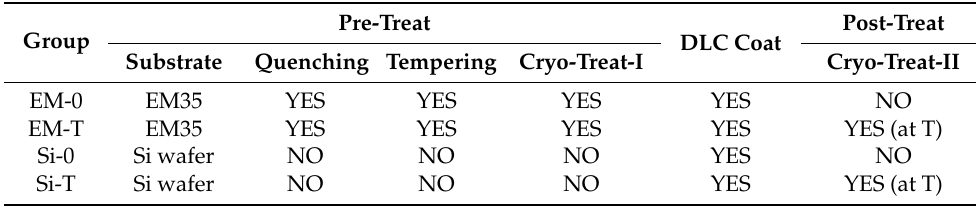
Table 1. Specimen groups and their processing